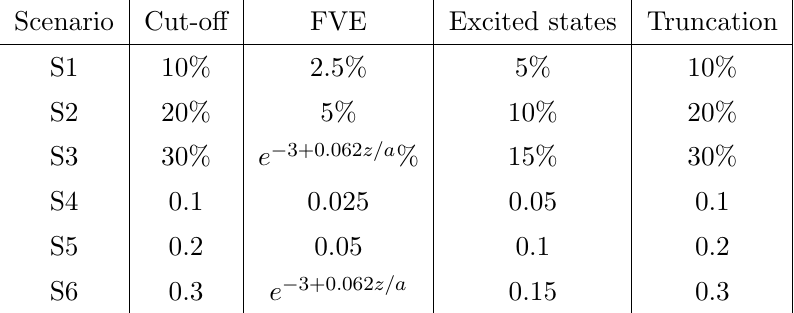
Table 1 . Scenarios of the impact of di(cid:11)erent systematic e(cid:11)ects in the renormalized matrix elements of quasi-PDFs. Percentage values for scenarios S1-S3 should be understood as a given fraction of the central value of the matrix element, while absolute values for S4-S6 are shifts independent from the matrix